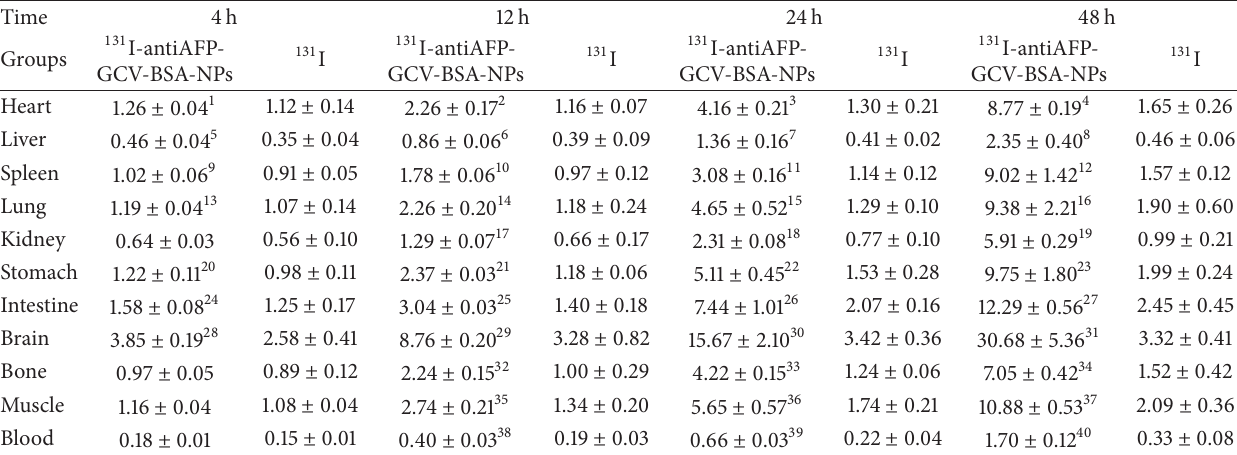
Table 1: T/NT of 131 I-antiAFPMcAb-GCV-BSA-NPs and 131 I in nude mice with transplanted hepatoma (mean ± SD, 𝑛 = 3 ). Time 4 h 12 h 24 h 48 h 131 Groups